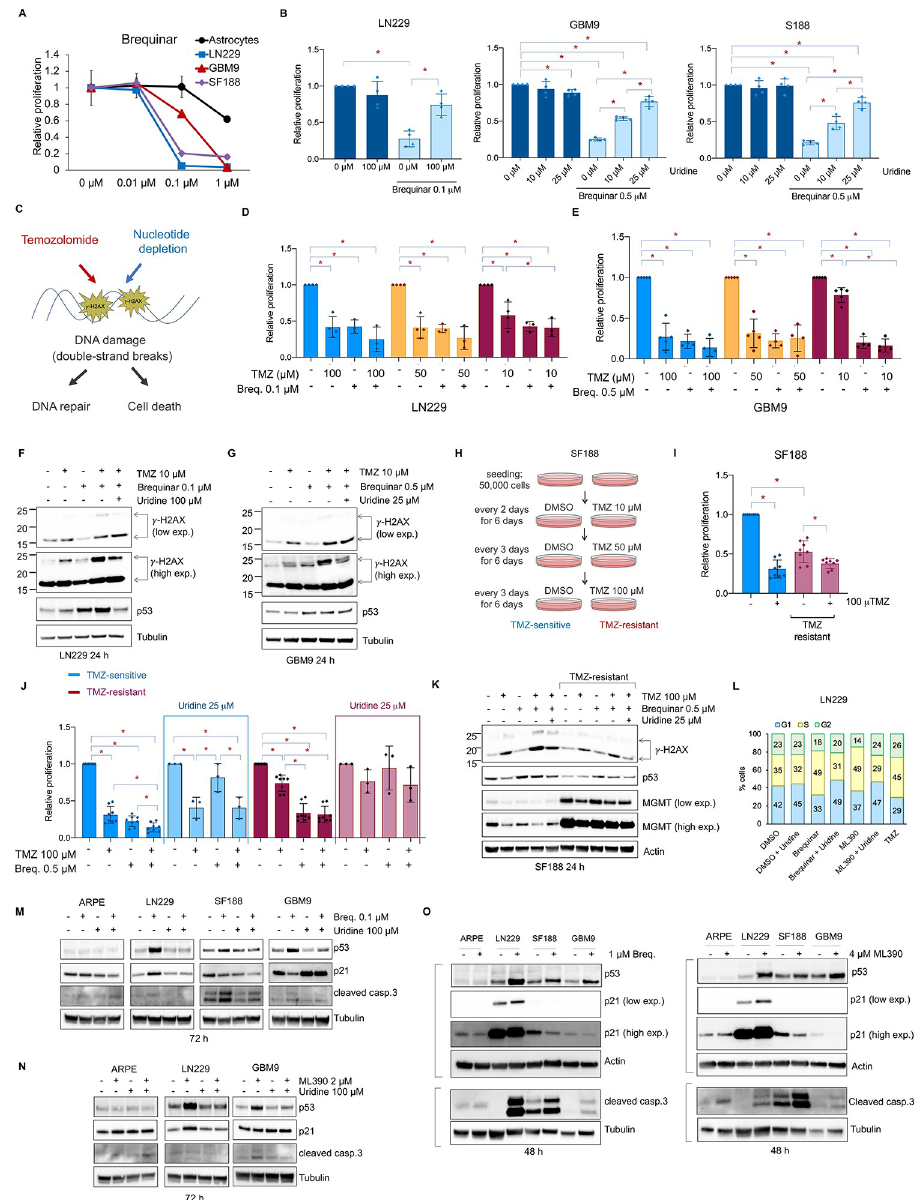
Fig 2. Inhibition of the de novo pyrimidine biosynthesis pathway decreases proliferation of temozolomide- sensitive and -resistant glioblasomta cells. (A) Relative proliferation of p14 ARF-/- human astrocytes, LN229, GBM9 and SF188 cells with increasing amounts of brequinar. Media with drugs was replaced every 2 days for 6 days. N = 3. (B) Relative proliferation of LN229, GBM9 and SF188 cells with or without brequinar and uridine. Media with drugs was replaced every 2 days for 6 days. N = 3–4. (C) Representation of the effects of temozolomide (TMZ) and the depletion of nucleotides causing DNA double-strand breaks and the phosphorylation of H2AX ( γ -H2AX). (D, E) Relative proliferation of LN229 and GBM9 in the presence of TMZ, brequinar (Breq.) or brequinar + TMZ. Media with drugs was replaced the day after seeding, and cell proliferation was measured 4 days later. N = 3–4. (F, G) Western blot of LN229 and GBM9 for γ -H2AX and p53. Also see Supplementary S2F and S2G Fig. (H) Representation of the in vitro generation of SF188 TMZ-resistant cells. (I) Relative proliferation of SF188 TMZ-sensitive and -resistant cells with or without TMZ. (J) Relative proliferation of SF188 TMZ-sensitive or -resistant cells with or without TMZ, brequinar or brequinar + TMZ with or without uridine normalize to each DMSO condition. Also see Supplementary S2H Fig. Media with drugs was replaced the day after seeding, and cell proliferation was measured 4 days later. (K) Western blot of SF188 TMZ-sensitive or -resistant cells with or without TMZ, brequinar or brequinar + TMZ with or without uridine for γ -H2AX, p53 and, MGMT. Also see Supplementary S2I and S2J Fig. (L) Cell cycle analysis